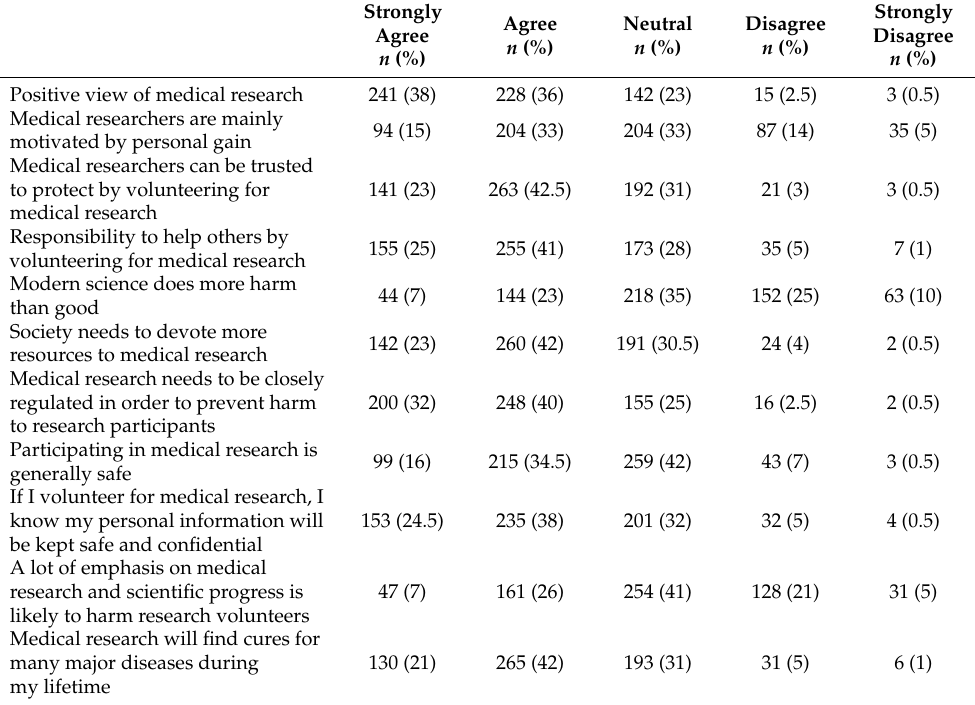
Table 3. Attitude towards biomedical